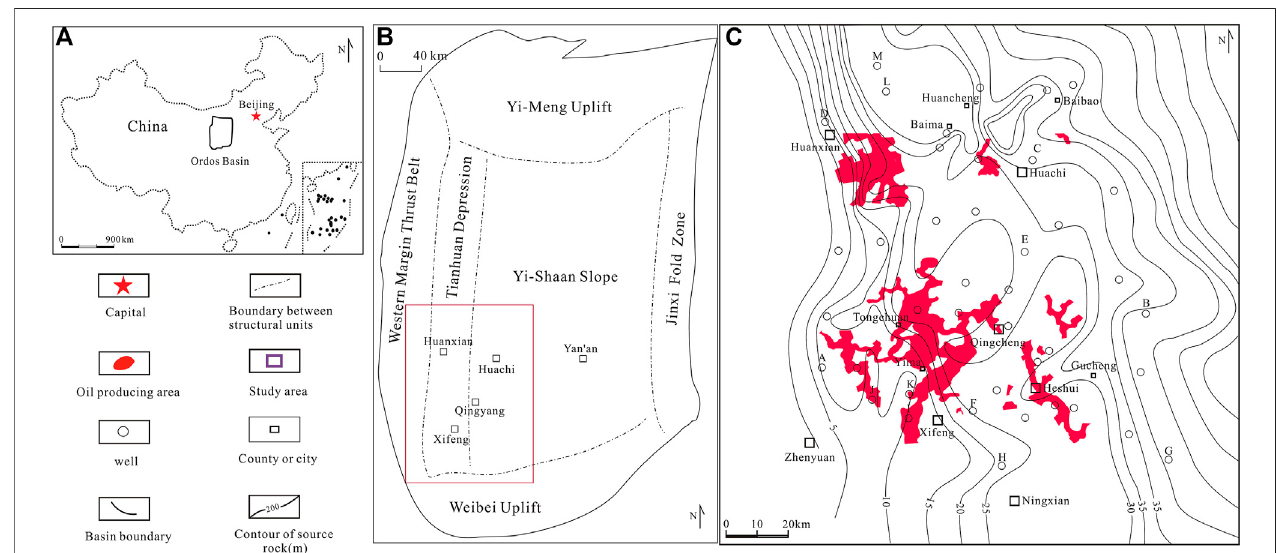
FIGURE 1 | (A) Geographic location of the Ordos Basin (B) Geographic location of the Longdong area in the Ordos Basin (C) distribution of Chang 7 high-quality source rocks [13] and the Chang 8 reservoirs.